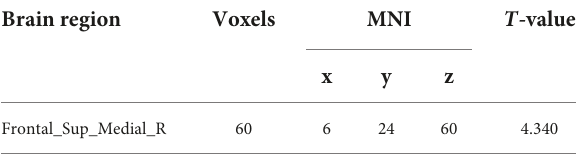
TABLE 2 Brain region showing decreased functional connectivity with Ch_123 in insomnia disorder.